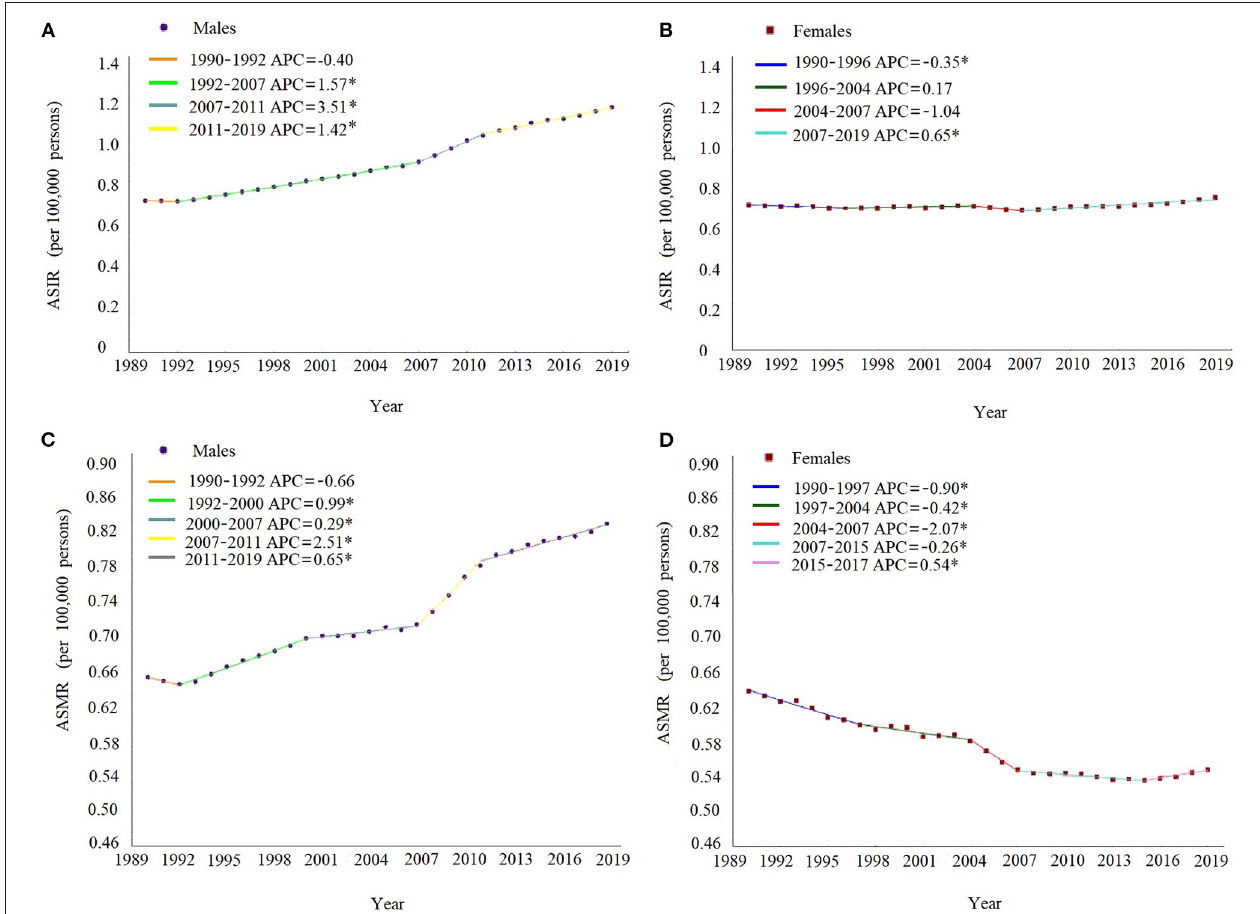
FIGURE 1 | Joinpoint regression analysis in sex-specific age-standardized incidence and death rates of multiple myeloma in China from 1990 to 2019. The ASIR in males (A) , ASIR in females (B) , ASMR in males (C) , and ASMR in females (D) . Notes: the annual percent change is statistically significantly different from zero at the a = 0.05 level. ASIR, age-standardized incidence rates. ASMR, age-standardized death